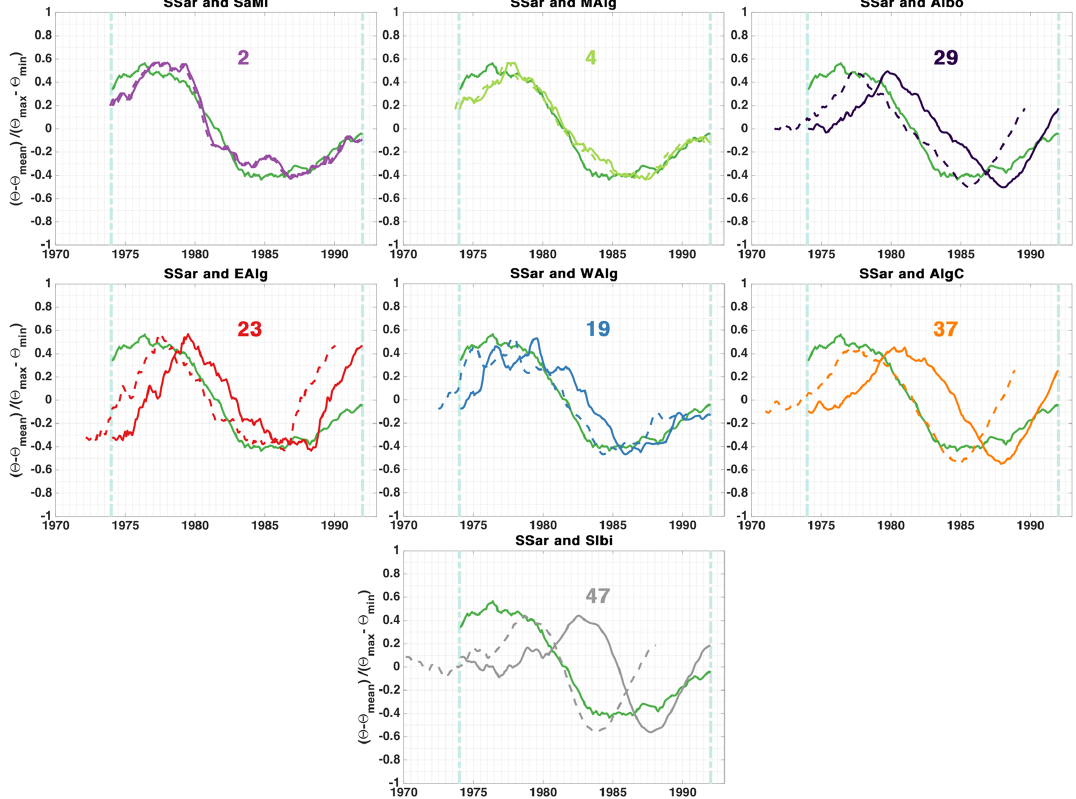
Figure 10. Cross-correlation of the cooling signal (1974–1992) between SSar and all the other regions. The solid lines represent the original position of the time series. The dashed line represent the time series with a lag that give the maximum correlation. The lag, in months, is written above the curves.